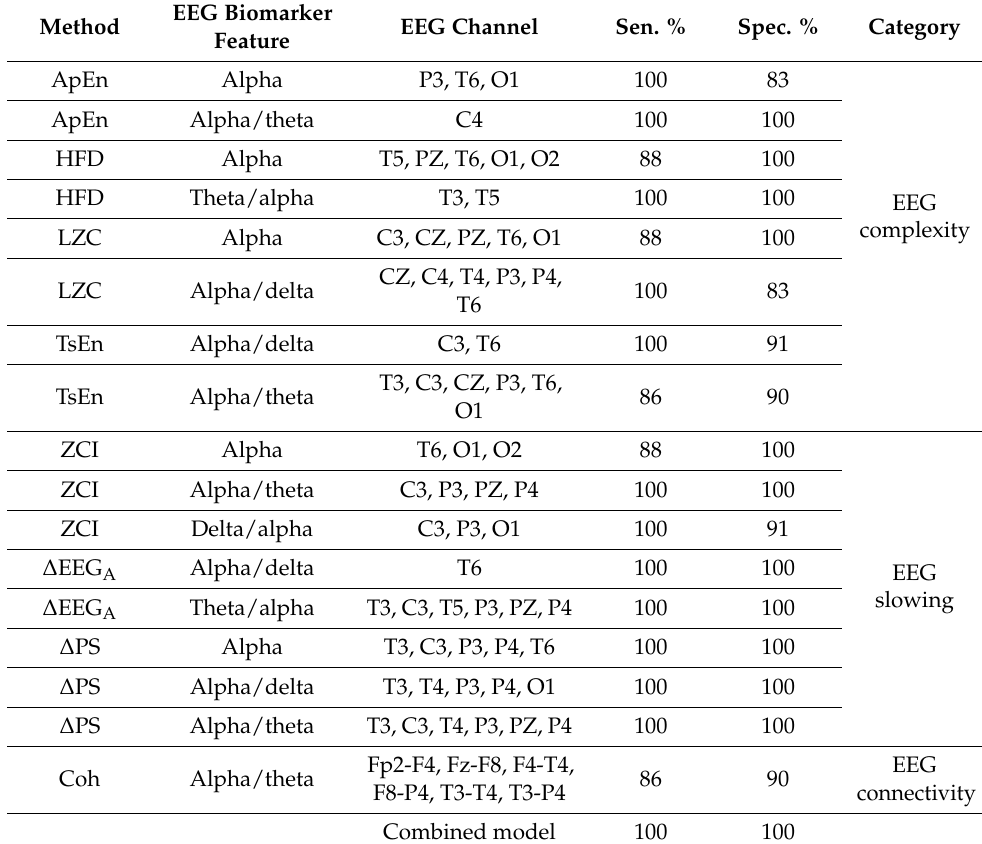
Table 7. Panel of robust EEG